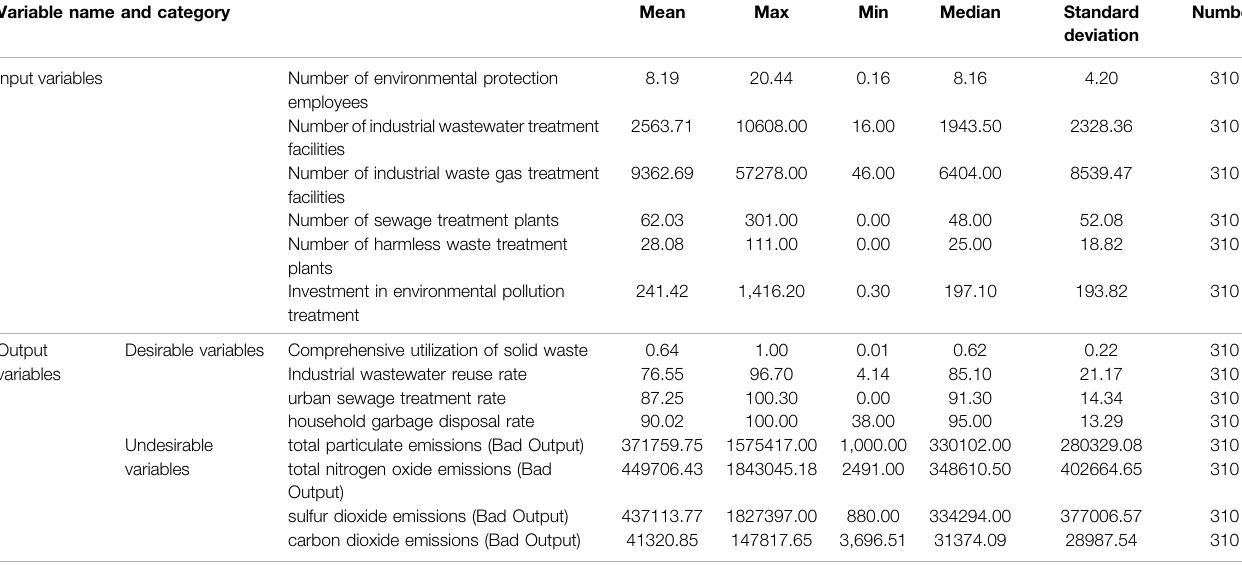
TABLE 3 | 31 Chinese provinces ’ input and output variables.